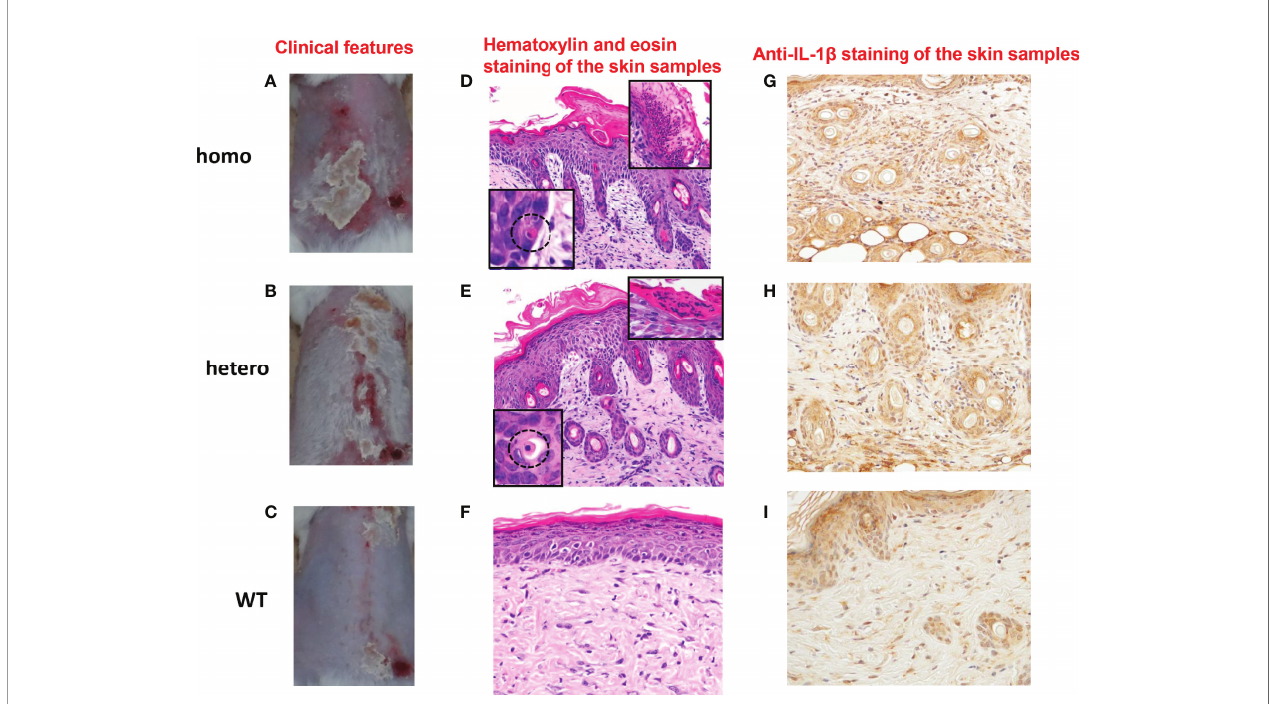
FIGURE 2 | Cutaneous in fl ammatory lesions induced by UVB irradiation in Nlrp1b KI mice. (A – C) Clinical features of Nlrp1b KI (homo) mice (A) , Nlrp1b KI (hetero) mice (B) , and WT mice (C) at 5 weeks of age, 9 days after UVB irradiation. (n ≧ 3) The Nlrp1b KI mice (A, B) show many scales on the back. (D – F) Hematoxylin and eosin staining of the skin samples reveals acanthosis, hyperkeratosis, in fl ammatory cell in fi ltration (D, E) , and dyskeratosis ( D, E insert) in the Nlrp1b KI mice, but such features are not seen or are mild in the WT mice (F) (original magni fi cation ×200). (G – I) In fl ammatory cell in fi ltration in the epidermis stained positive for IL-1b (original magni fi cation ×